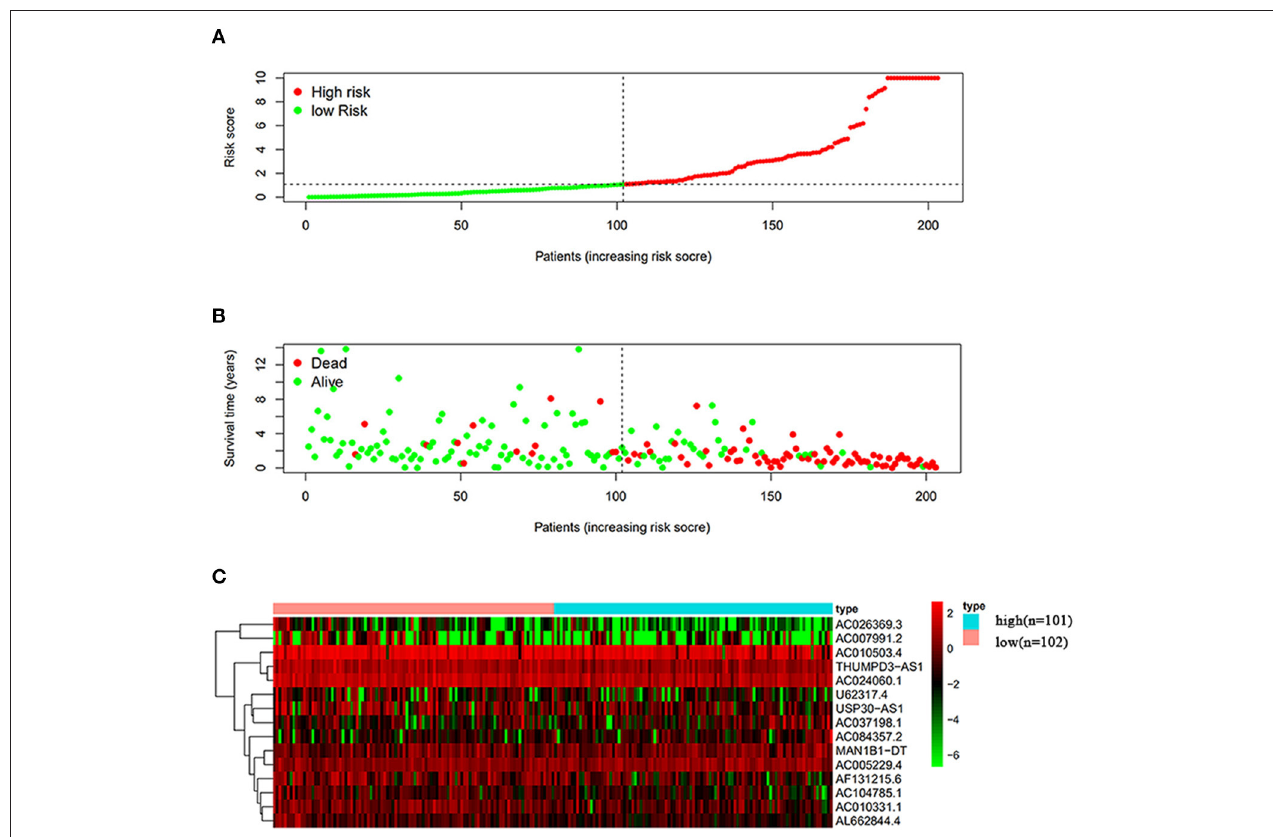
FIGURE 2 | Analysis of autophagy-related lncRNA risk scores of patients with BC in The Cancer Genome Atlas (TCGA) training group. (A) Patients with BC were divided into low-risk group ( n = 102) and high-risk group ( n = 101) based on the median-risk score. (B) Survival status and duration of the survival in patients with BC. (C) Heat map of the expression of 15 key lncRNAs in BC. The color from green to red shows the expression trend from low level to high level.